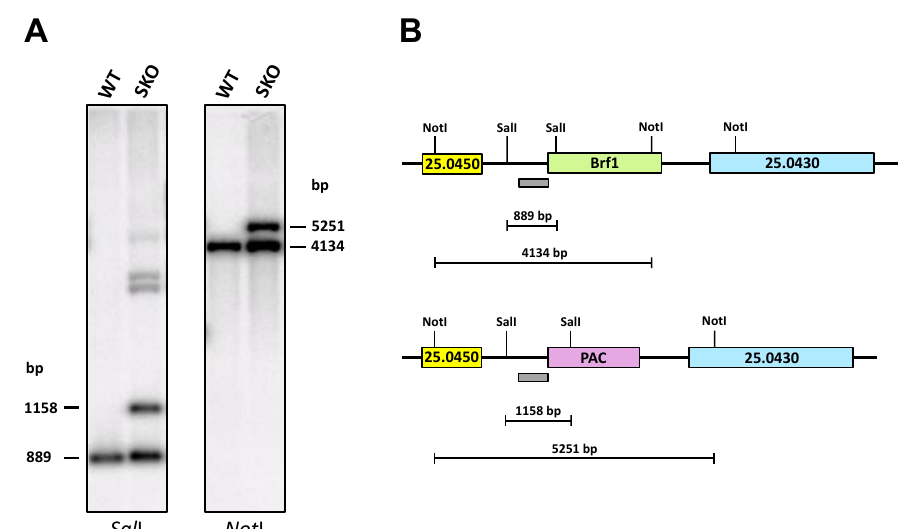
Figure 4. Southern blot analysis of LmBrf1 single-knockout parasites. ( A ) Genomic DNA from a single-knockout clone (SKO) and wild-type parasites (WT) was digested with Sal I and Not I. The probe corresponded to the 5 ’ -targeting region of the LmBrf1 gene. The size of the observed bands is indicated. The larger fragments observed with DNA from the SKO clone digested with Sal I correspond to partial digestion of the enzyme. ( B ) Restriction maps of the wild-type LmBrf1 locus (top map) and mutant loci with a copy of LmBrf1 replaced with the pac gene (bottom map). Sizes of predicted restriction fragments after digestion with Sal I and Not I are shown. The location of the fragment employed as a probe is indicated with a gray bar.